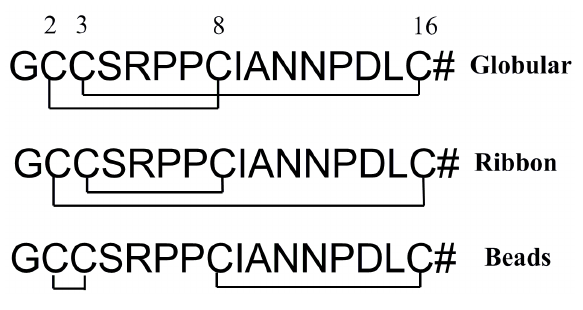
Figure 1. A schematic representation of globular (native), ribbon and beads isomers’ disulfide connectivities of α -CTx TxIA. #, amidated COOH